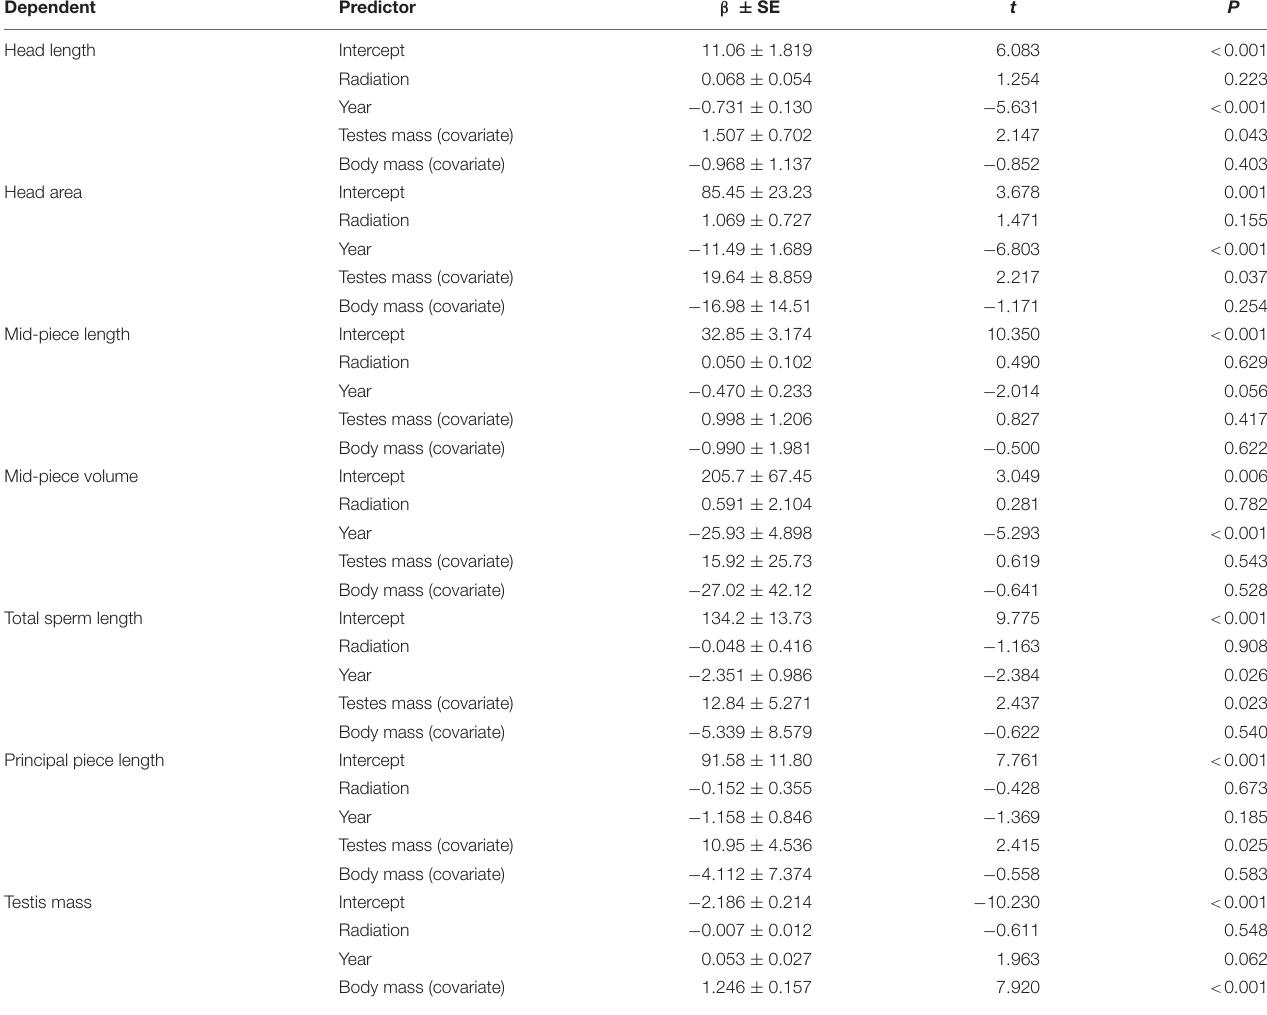
TABLE 1 | Relationship of radiation and sperm morphology in 49 bank voles. We analyzed male sperm morphological traits in relation to radiation (log 10 ) and testes as well as body mass (to account for the reproductive status of each male) in separate GLMMs (see material and methods for models). After correction for multiple testing, α is set at